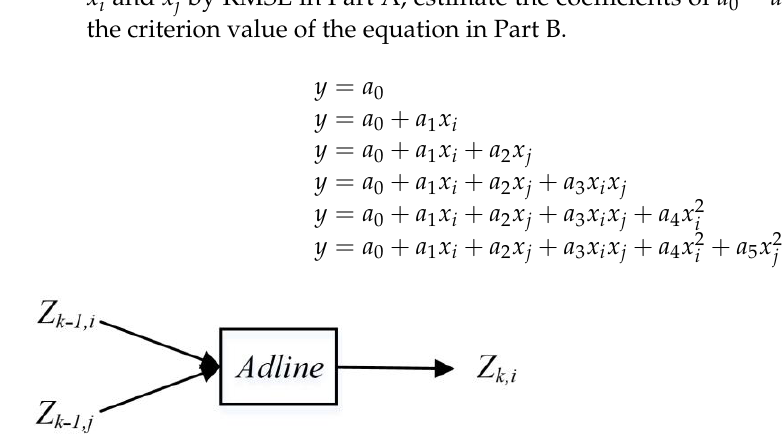
Figure 4. Neuron in the GMDH network (except input-layer neurons).